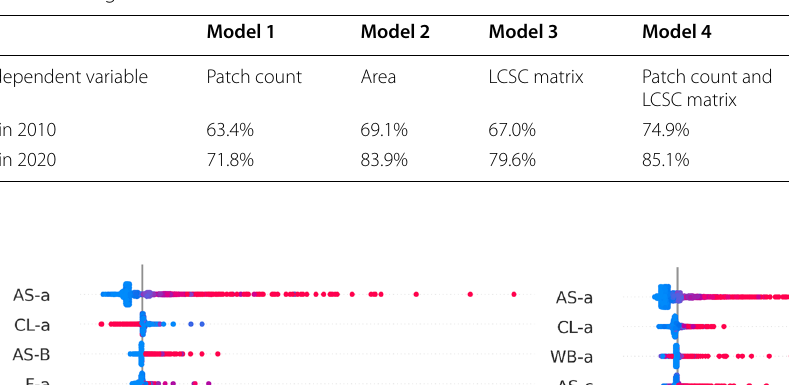
Table 1 Fitting of six XGBoost models in 2010 and 2020